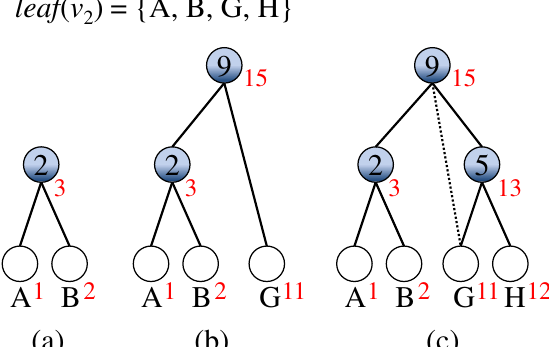
Figure 3. An example of constructing the subtree T (cid:48) with respect to leaf ( v 2 ) in Figure 2. ( a ) The 2 initialization of T (cid:48) . ( b ) The intermediate of T (cid:48) as node A is processed. ( c ) The complete subtree T (cid:48) 2 2 node B is processed. As the mutation time of lca (B, G) is larger than the time of lca (G, H), the dotted line incident to G is removed and the other incident edge of G is